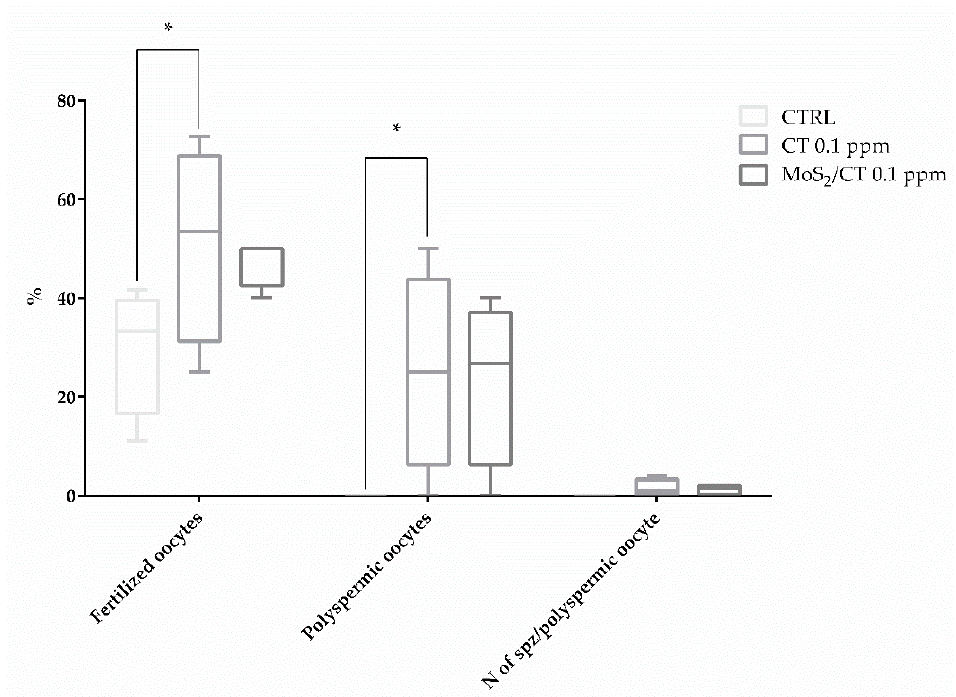
Figure 7. IVF outcomes. Three different groups were subjected to IVF assay: CTRL, CT 0.1 and MoS 2 /CT 0.1 ppm. Data are expressed as percentages, showing the number of fertilized oocytes, the number of polyspermic oocytes and the number of spermatozoa per polyspermic oocyte, comparing the groups of spermatozoa capacitated in the presence of MoS 2 /CT and CT (0.1 ppm) to the control group. Data were analyzed using Dunnett’s test. * p < 0.05 versus control. Four independent experiments were performed.